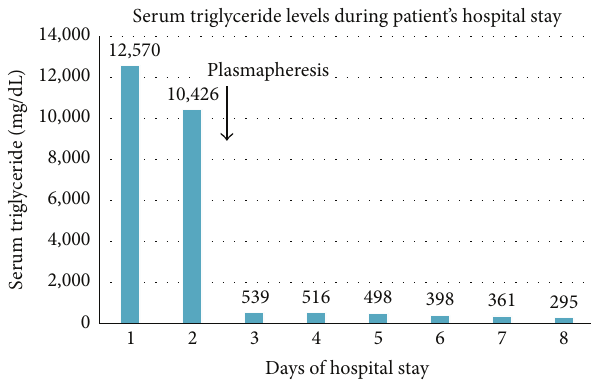
Figure 3: Decline in serum triglyceride level after plasmapheresis was performed on day 2 of